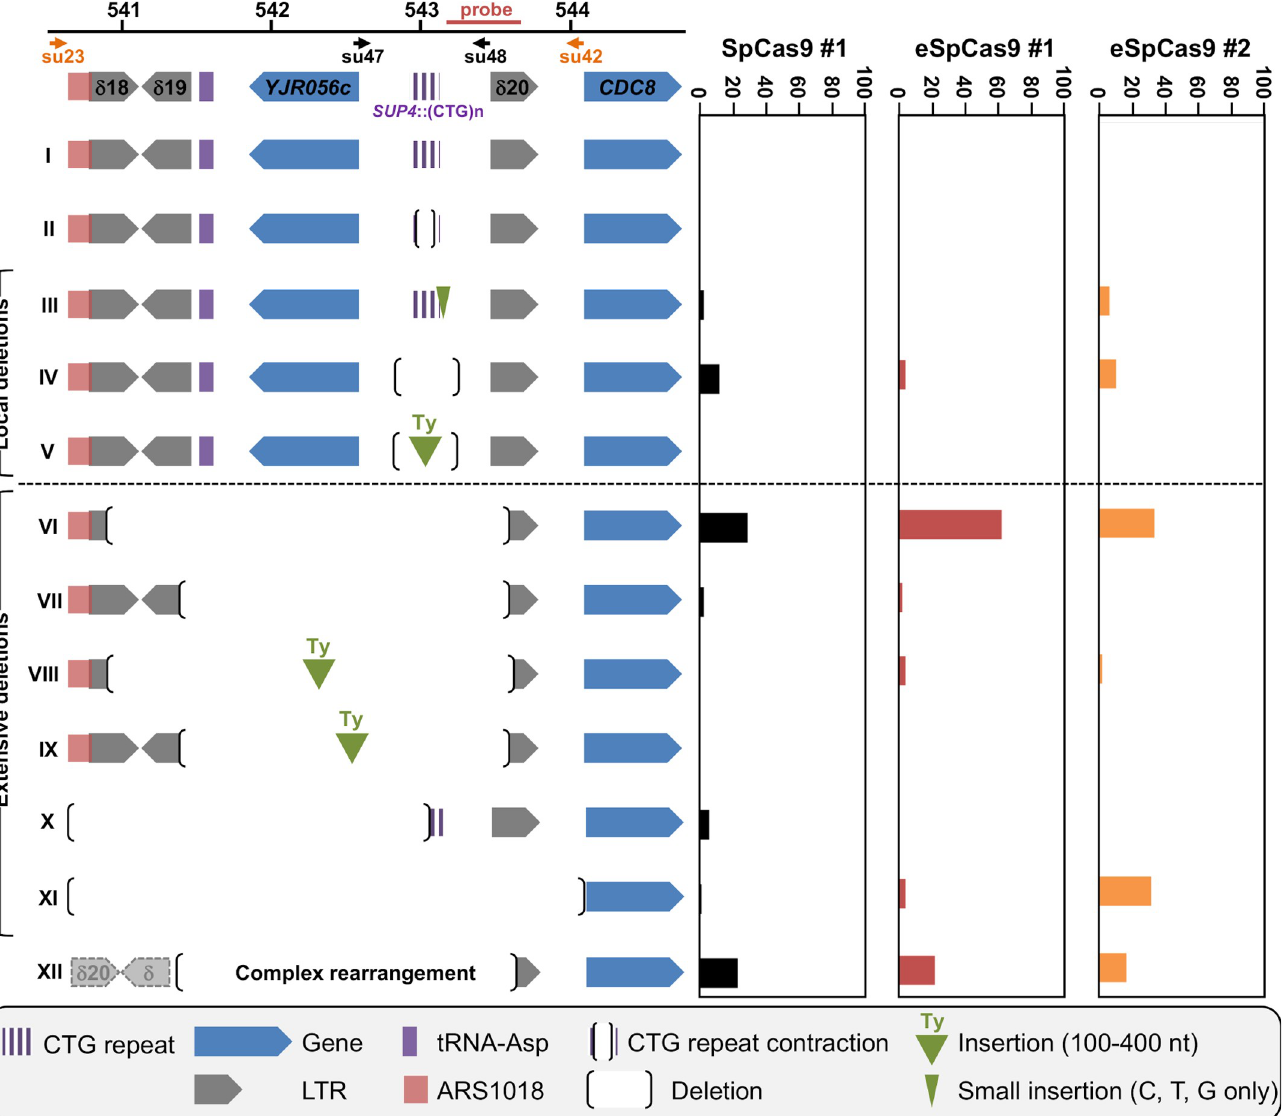
Fig 5. Summary of chromosomal rearrangements observed in following Sp Cas9 and enhanced Sp Cas9 (e Sp Cas9) inductions. See Fig 4 for legend. e Sp Cas9 #1 and #2 refer respectively to guide RNAs #1 and #2 described in Fig 1A. The following number of surviving clones were analyzed: Sp Cas9: 51, e Sp Cas9 #1: 49, e Sp Cas9 #2: 48. See text for